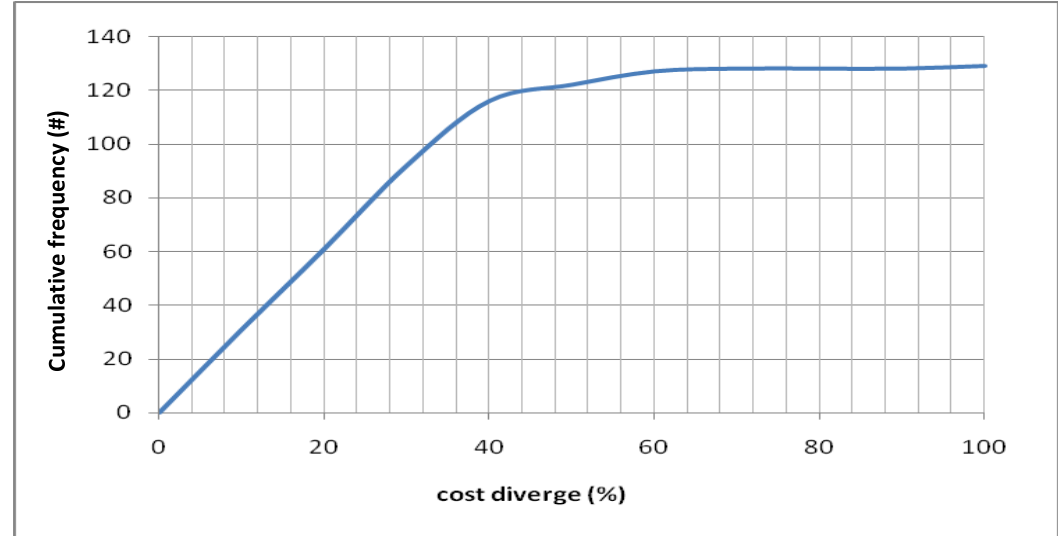
Figure 1 S-curve of cost under estimation in road construction projects in the West Bank